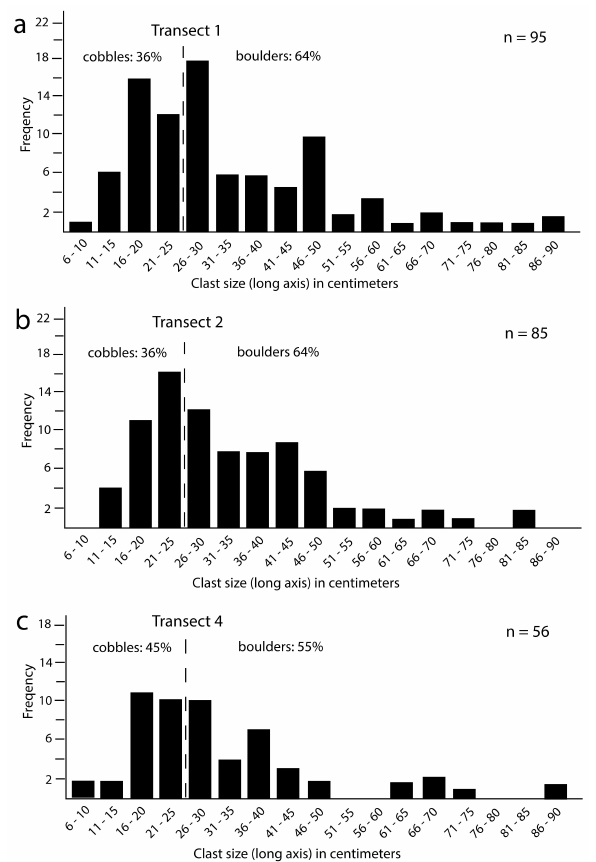
Figure 6. Set of bar graphs used to appraise variations in maximum boulder length from the three transects with similar orientations closest to the source of coastal erosion; ( a ) Bar graphs from transect 1; ( b ) Bar graphs from transect 2; ( c ) Bar graphs from transect 4. Transect 3 is excluded from this treatment on account of its deviant